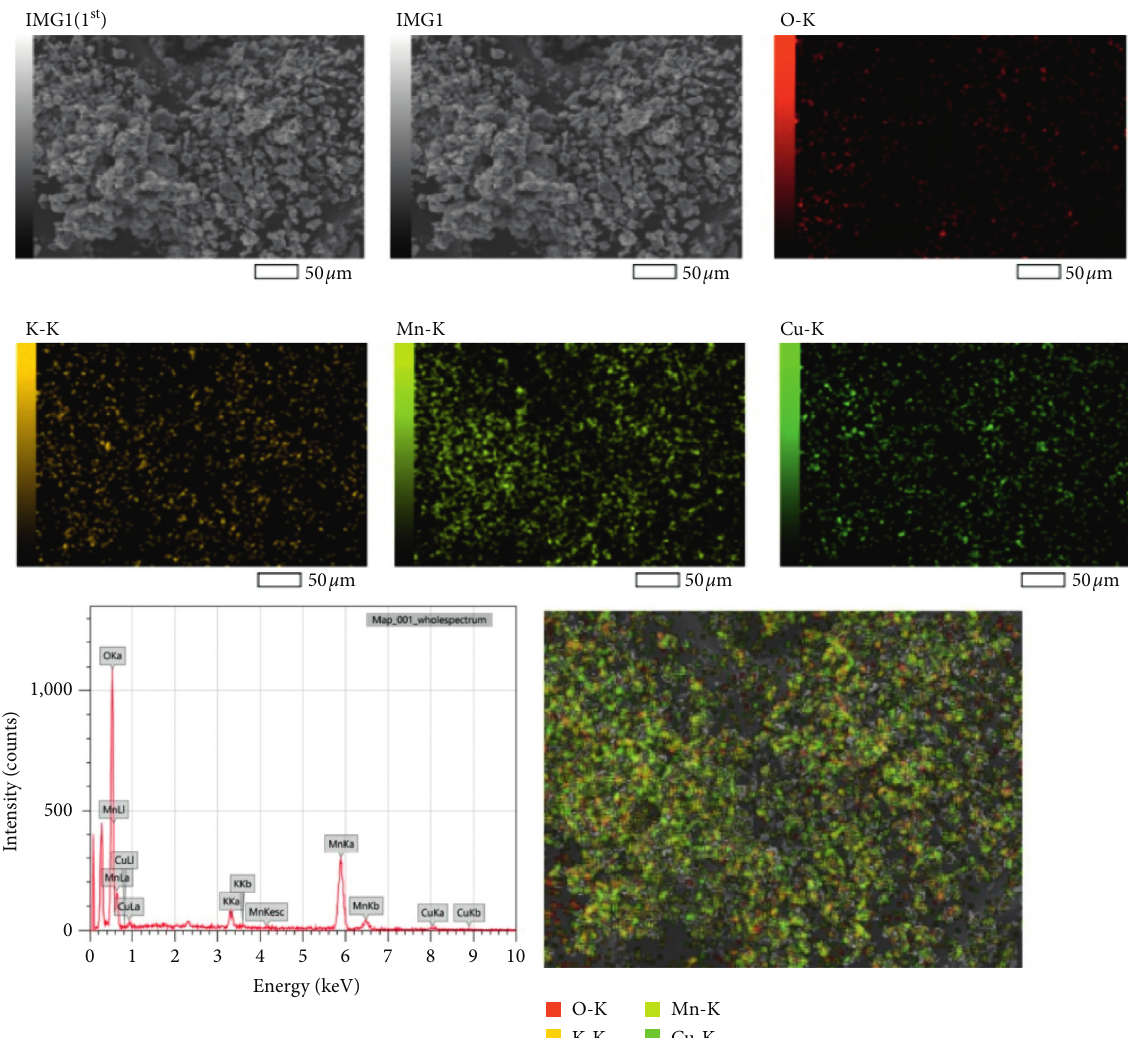
Figure 2: SEM-mapping and EDS images of CuMnO